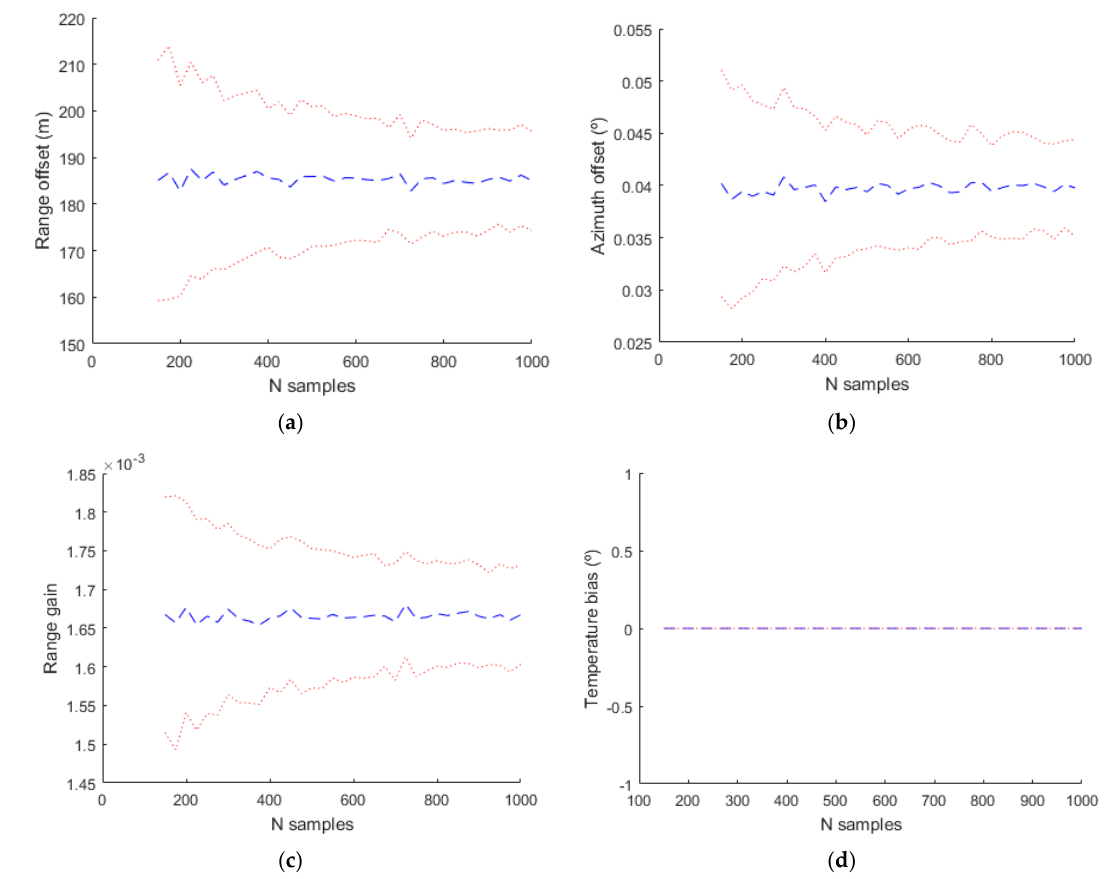
Figure 13. Estimated bias values for Radar 1 using only the model with the parameters ∆ ρ 0 , α 1 , θ 0 , s ant , β axis and α axis . ( a ) Range offset; ( b ) Azimuth offset; ( c ) Range gain; ( d ) Temperature